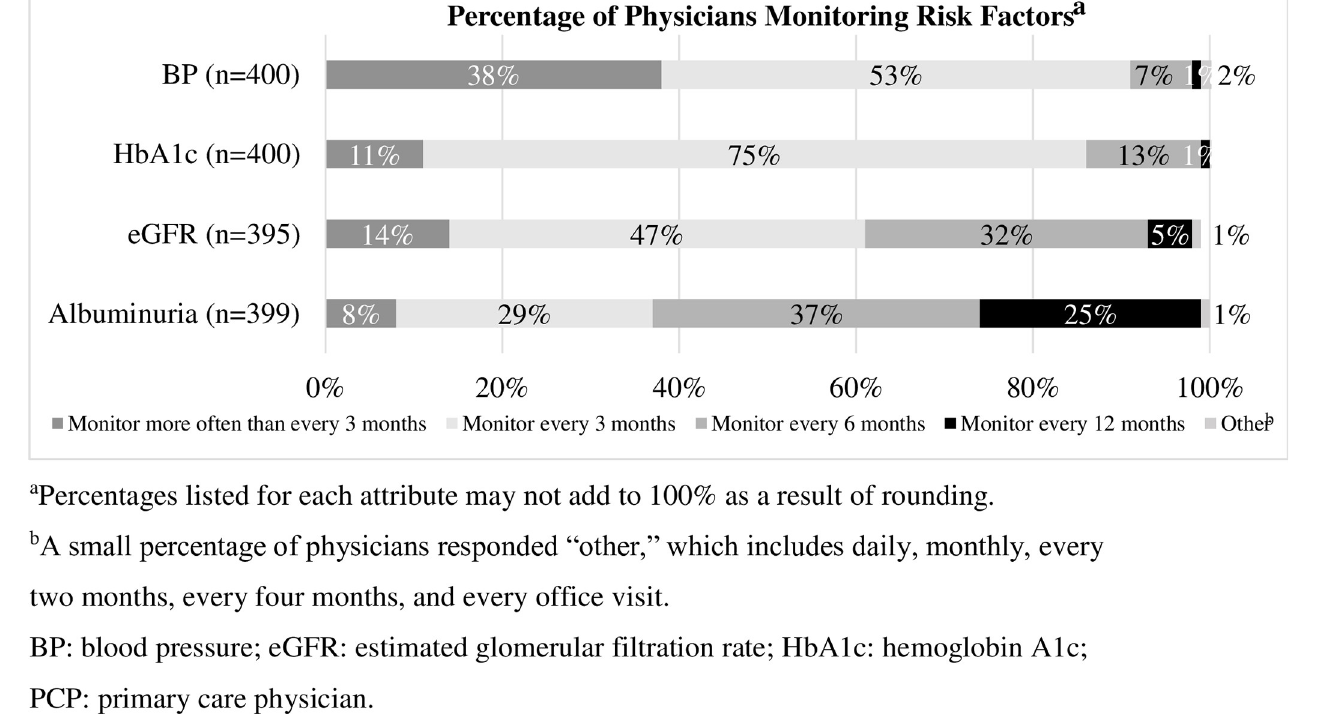
Fig 3. Frequency of monitoring of type 2 diabetes mellitus patients.